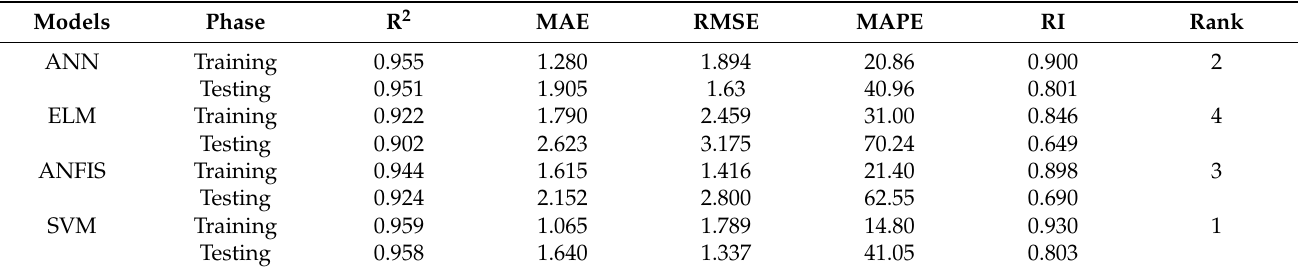
Table 4. Performance evaluation. Table 5. Comparison of the results with the existing AI models.